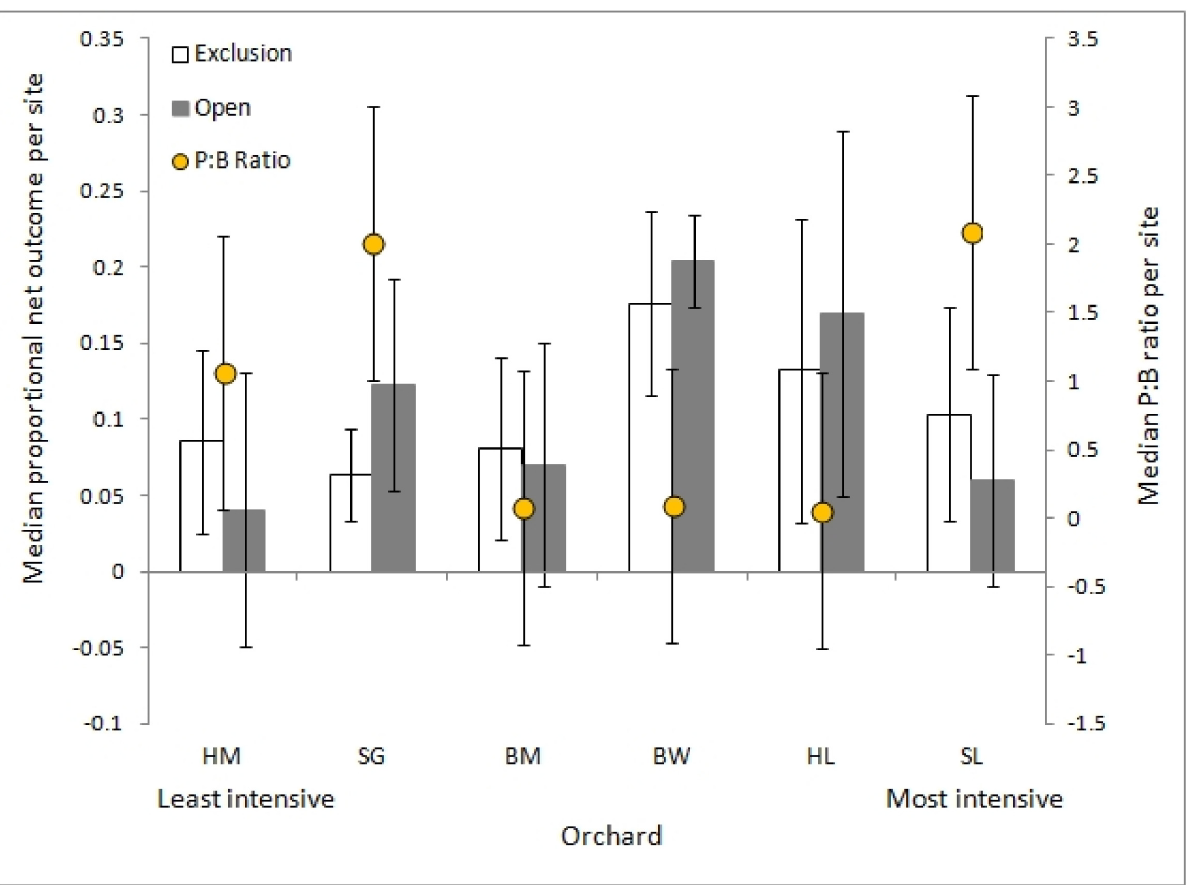
Fig 2. The median ( ± SD) proportional net outcome of arthropod activity in terms of yield (pollination success — pest damage) and the median ( ± SD) P:B ratio differed between individual orchards. The net outcome value represents the number of undamaged fruit as a proportion of the number of initial blossoms per branch; the P:B ratio is the ratio of pest arthropods to beneficial arthropods per site, where large values indicate that pest arthropod abundance exceeded beneficial arthropod abundance (S1 and S3 Tables).